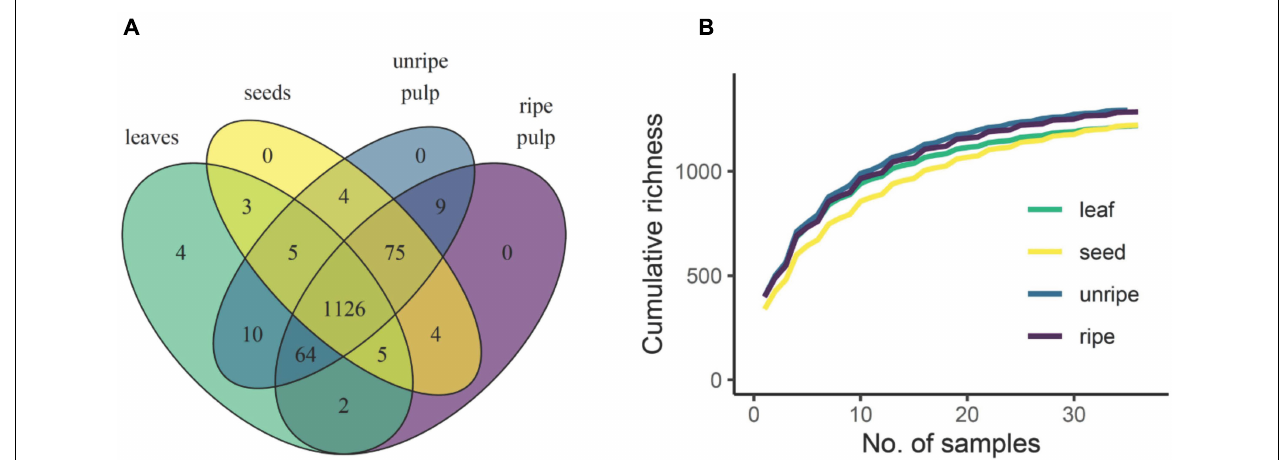
FIGURE 1 | Chemical gamma diversity parsed by organ type. A Venn diagram (A) shows the total number of compounds detected across all samples that were unique and shared across organ types. The rarefaction curve (B) shows how compound richness accumulates with sampling scale in each organ type. Curves represent an average across 5,000 bootstrapped accumulation curves with random starting points. Because samples from the same species were not independent, the rarefaction was constrained by species such that samples from the same species were always added in sequence. TABLE 1 | Summary of GNPS molecular network annotations and class-level compound richness. Chemical class a Examples of class known from Piper